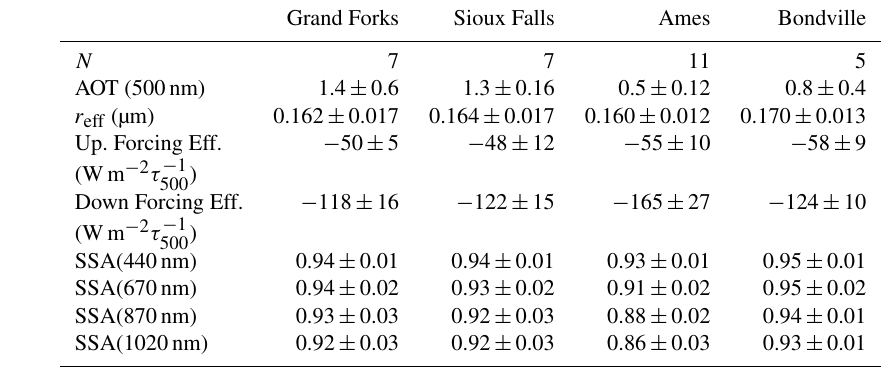
Table 2. Averaged aerosol-related properties, including effective radius ( r eff ), upwelling and downwelling aerosol forcing efficiencies (at 500nm), and single scattering albedo (SSA), corresponding to Dubovik retrievals from measurements from four selected AERONET stations for 29 June–3 July 2015.